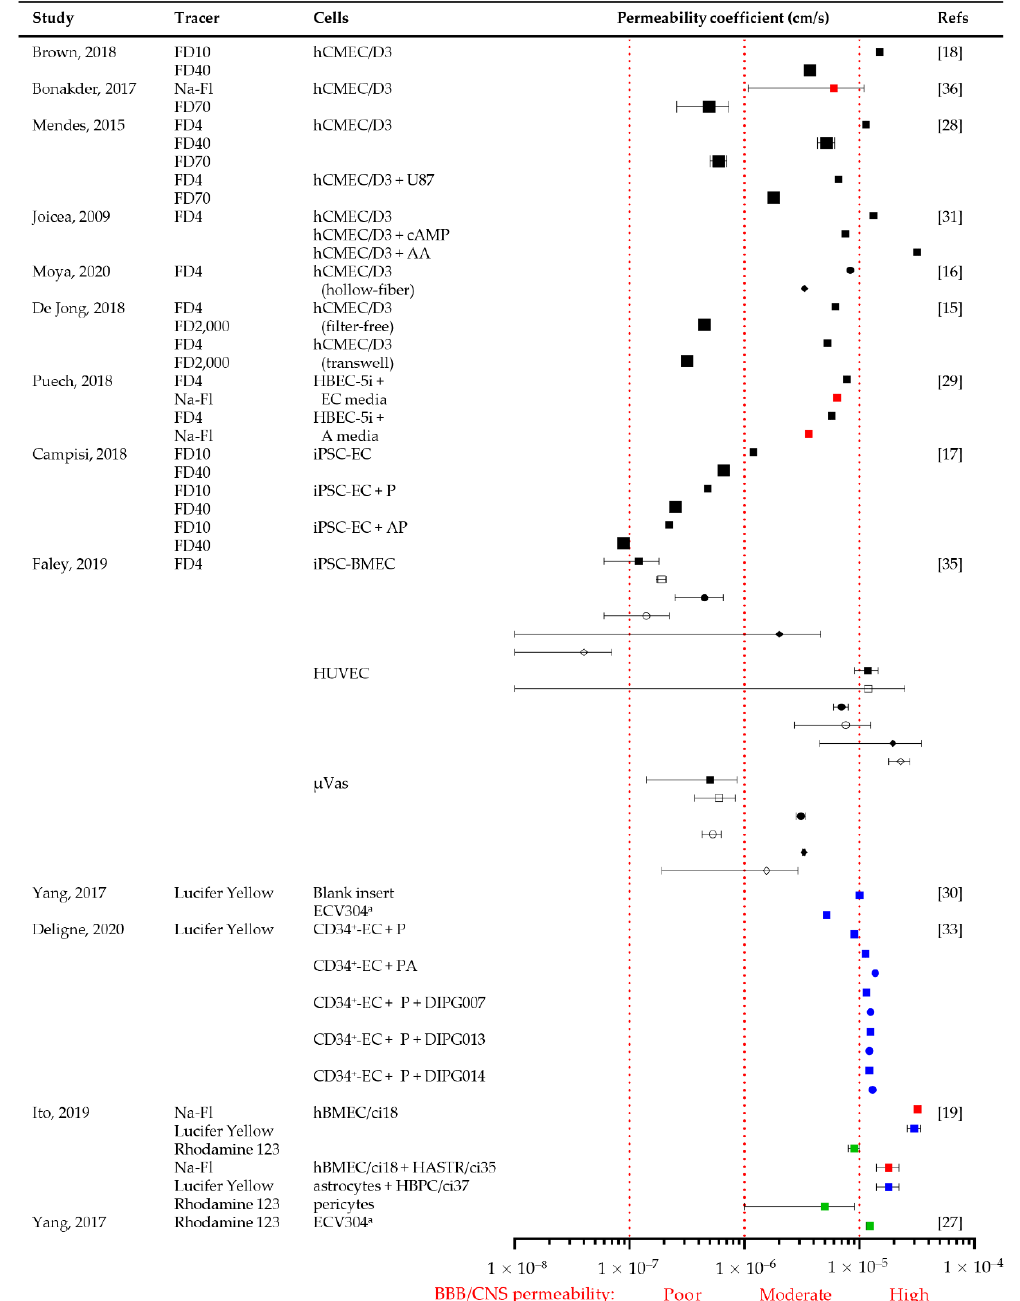
Figure 5. In vitro permeability coefficient values for fluorescent tracers. Forest plot shows permeability coefficients determined for FITC-dextran (FD ≤ 10 kDa ■ or ≥ 40 kDa; ■ ), sodium fluorescein (Na-Fl; 376 Da; ■ ); Lucifer Yellow (452 Da; ■ ) and Rhodamine123 (381 Da; ■ ; P-gp substrate) in in vitro BBB models using stem (iPSC), primary and immortalized ECs with or without astrocyte (A), pericytes (P) and neurons (N). Symbols show mean ± SD for the reported experiments at day 1 ( ■ ), 7 ( ● ) and 14 ( ◆ ) and under static ( ■ ) or perfused conditions ( ● ). a ECV304 was later identified to be a human urinary bladder carcinoma cell line, presenting many EC phenotypic characteristics [30]. High, moderate and poor CNS/BBB permeability is denoted by red dotted lines at >10 −5 , 10 −6 , and 10 −7 cm/s, respectively. Seven studies (63.6%) used immortalized ECs (hCMEC/D3, HBEC-5i and ECV304). Permeability was inversely correlated with tracer size (molecular weight) [18,28,29]. The lowest permeability was detected in hollow-fiber followed by filter-free and transwell